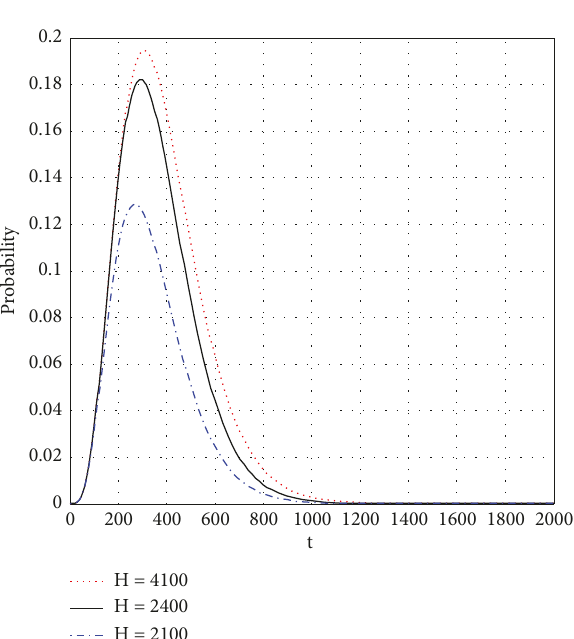
Figure 15: Sensitivity analysis of (P)